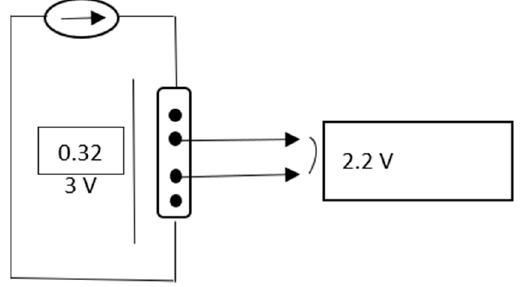
Figure 2. Mounting of the four-point